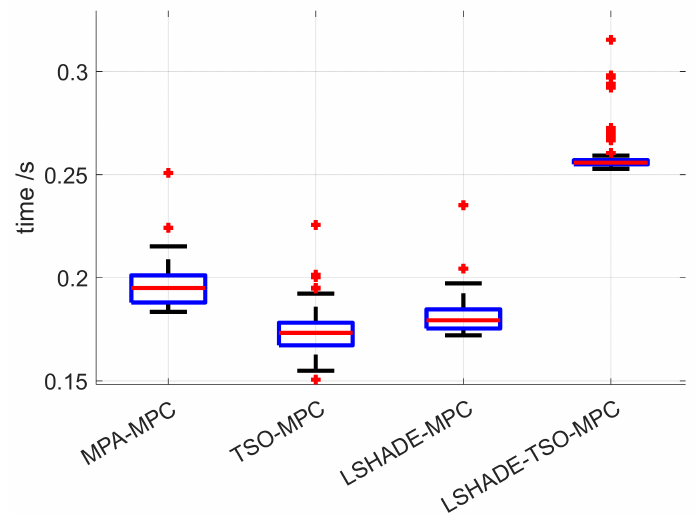
Figure 22. Box plot of algorithm decision